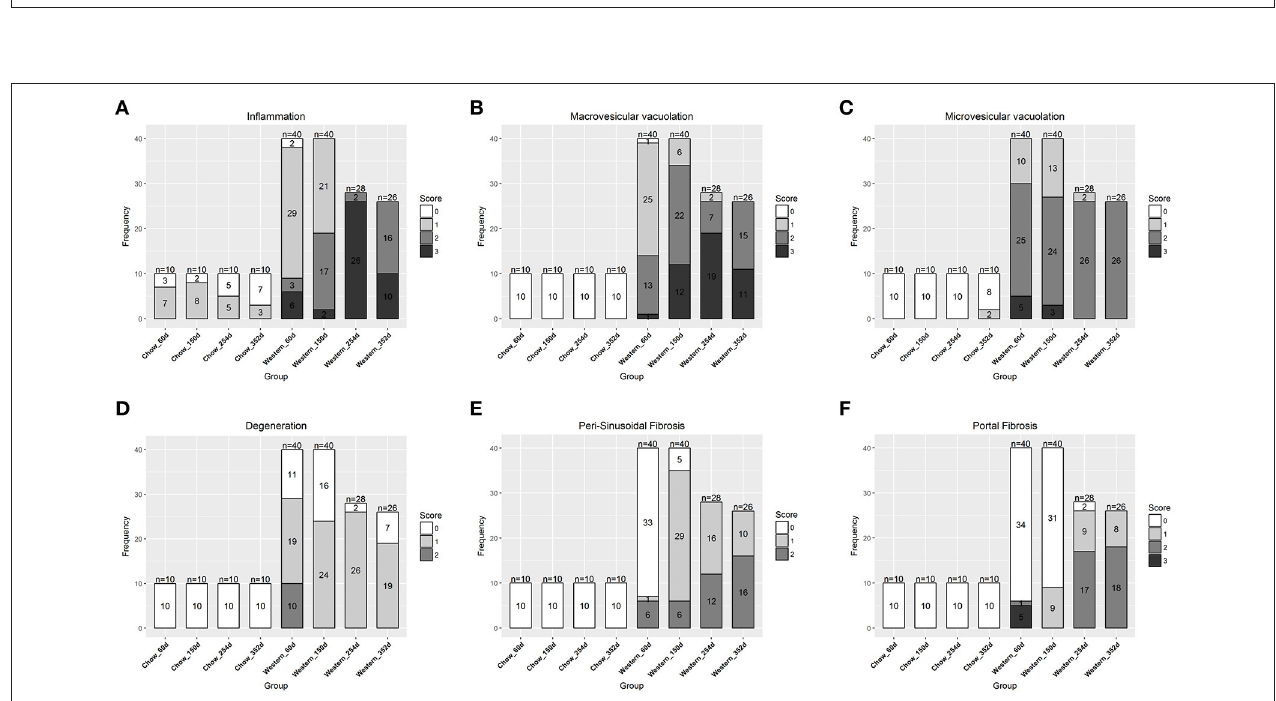
FIGURE 2 | Progression of hepatic lesions in the NASH mice fed Western diet. Male C57BL/6J mice were fed chow or Western diet for different durations. The right and left lateral lobes were collected, and analyzed. The pathological scores from both lobes of an animal were pooled when performing categorical analysis. Hepatic inflammation (A) , macrovesicular vacuolation (B) , microvesicular vacuolation (C) , hepatocyte degeneration (D) , perisinusoidal fibrosis (E) , and portal fibrosis ( F) were graded.